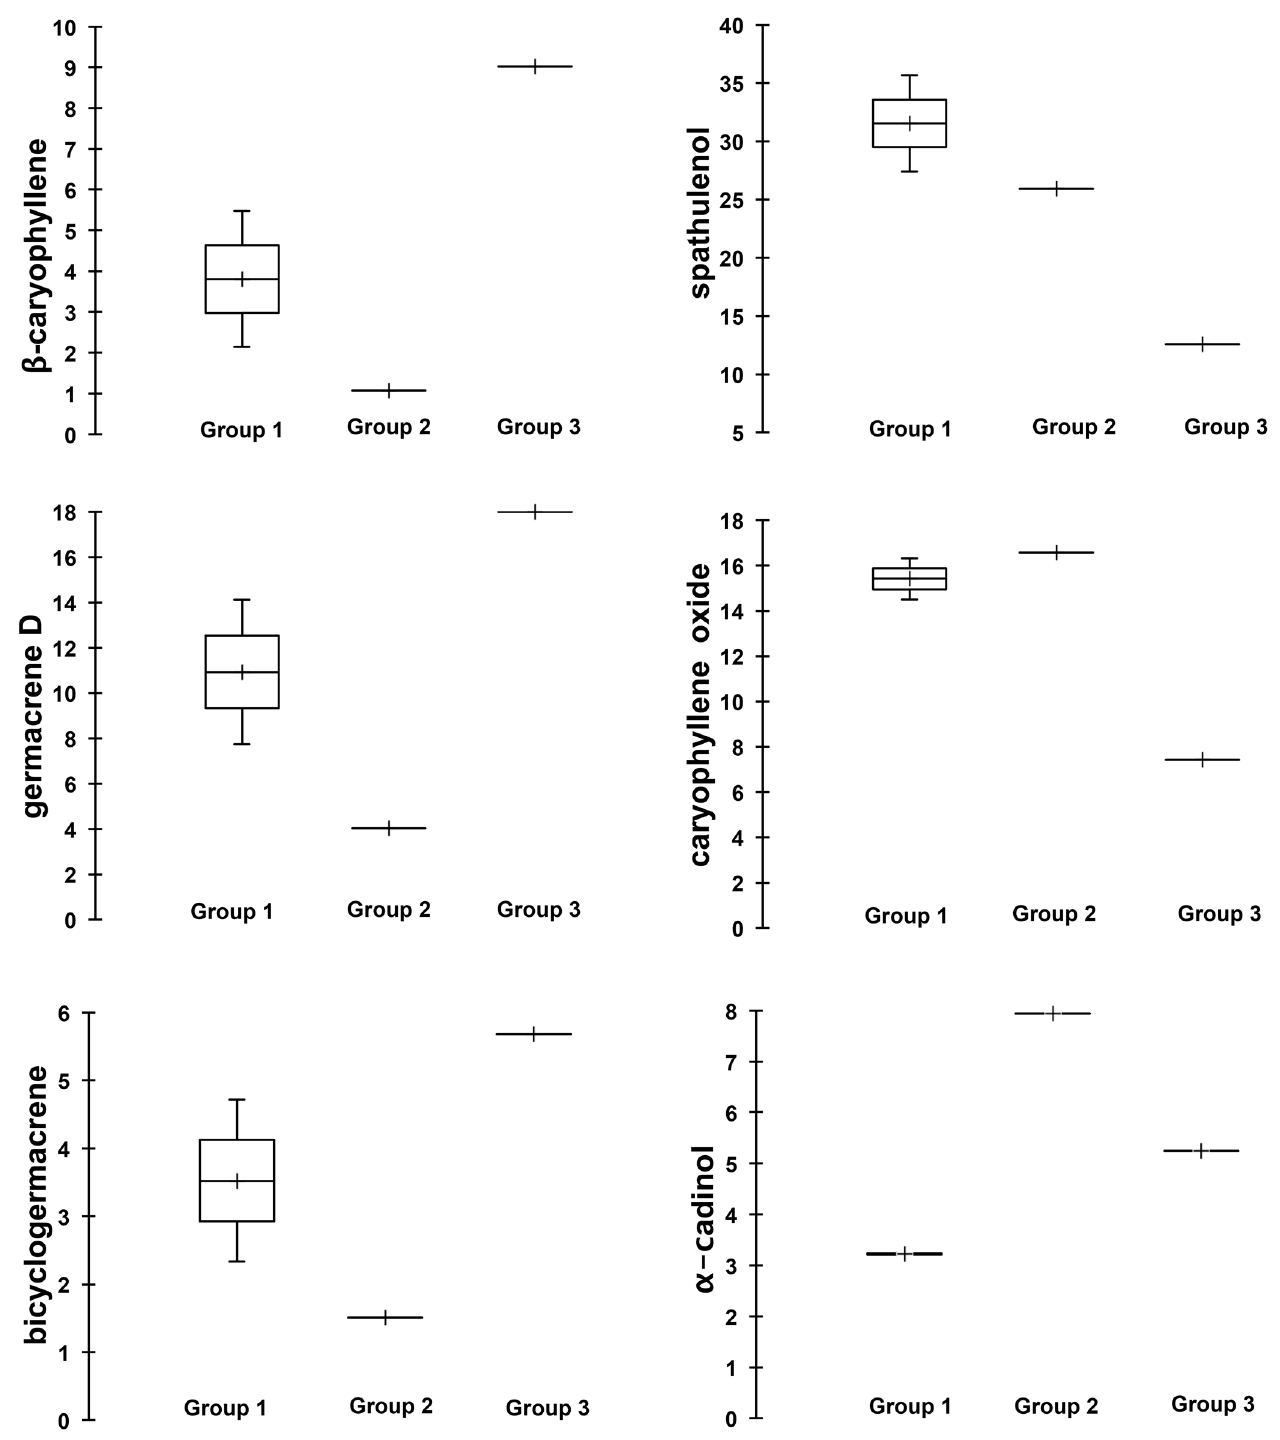
Fig 3. Box plot analyses of the major compounds (%) present in the essential oil from leaves of Copaifera langsdorffii Desf. β -Caryophyllene, germacrene D and bicyclogermacrene (non-oxygenated sesquiterpenes); spathulenol, caryophyllene oxide and α -cadinol (oxygenated sesquiterpenes). Wet season at 6:00 am and wet season at 5:00 pm — Group 1; dry season at 6:00 am — Group 2; dry season at 5:00 pm — Group 3.